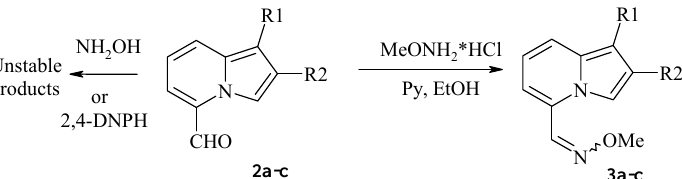
Table 3. Characteristics of O-Me oximes 3 of 5-formylindolizines